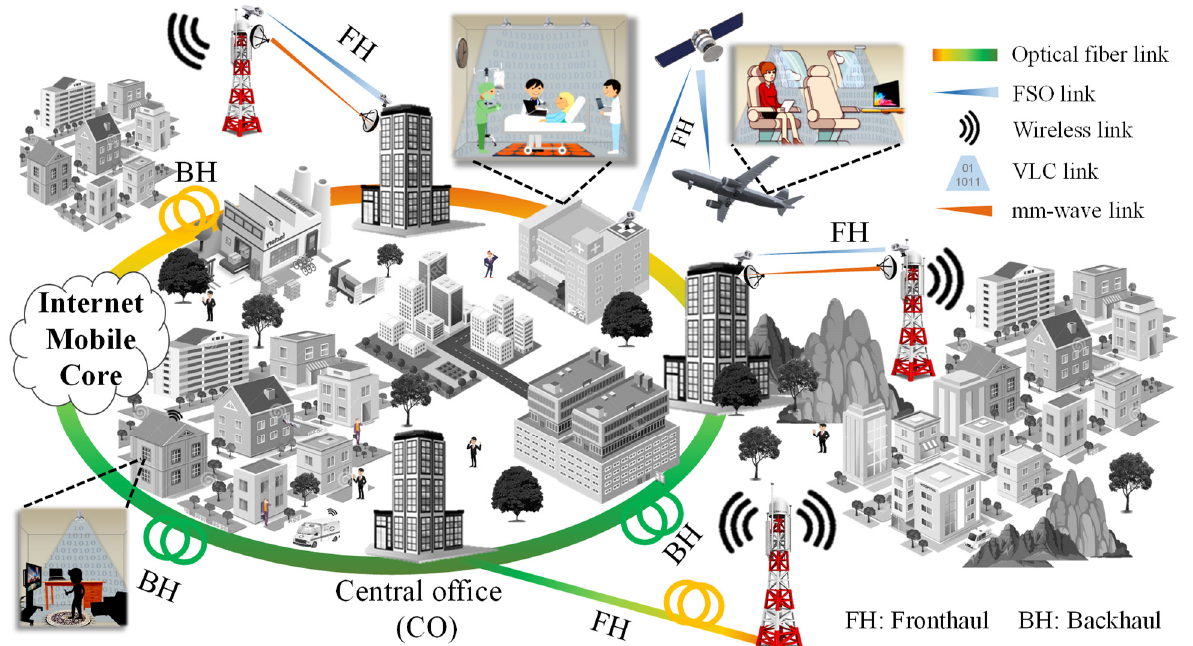
Figure 1. Optical-wireless communication system based on RoF/FSO/wireless fronthaul configurations combined to VLC/wireless access for 5G and beyond.